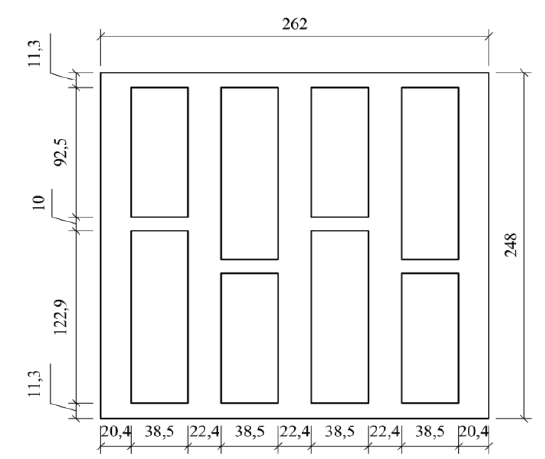
Figure 5. Cross-sectional geometry of the composite element under study.